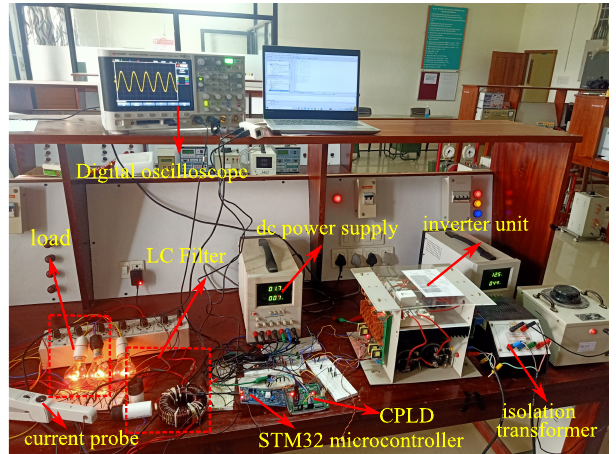
Figure 20. Hardware set